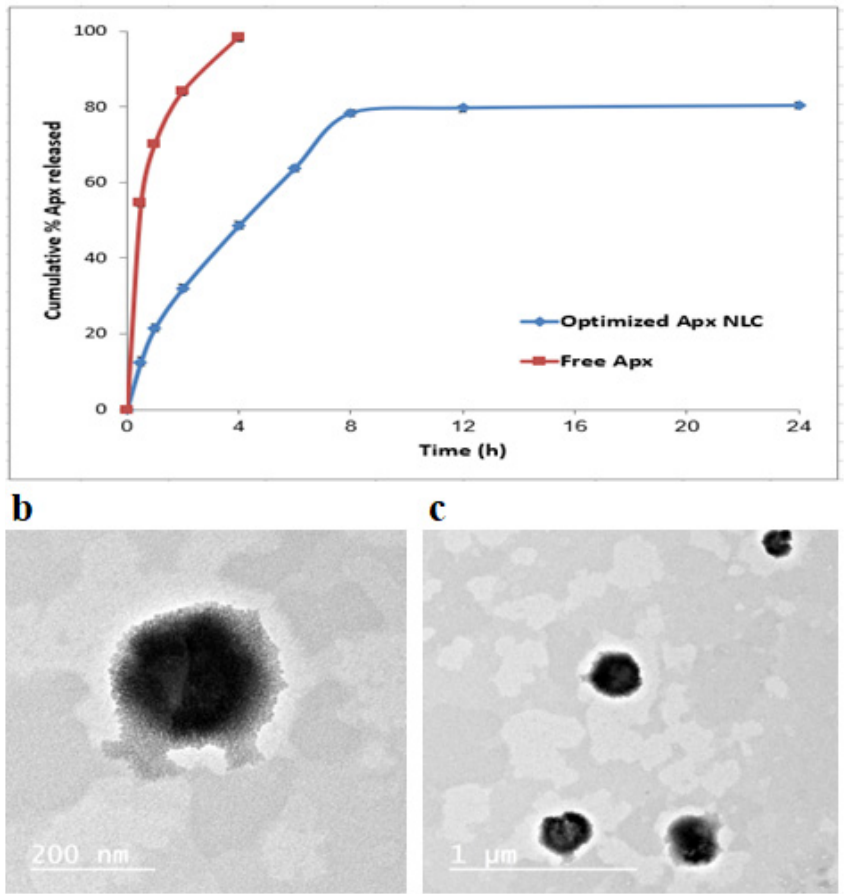
Figure 4. In vitro release profiles for the optimized formulation compared with the free drug in suspension (mean ± SD, n = 3) ( a ); photomicrograph of the optimized Apx-NLCs formulation by TEM images ( b , c ) at different magnification power.